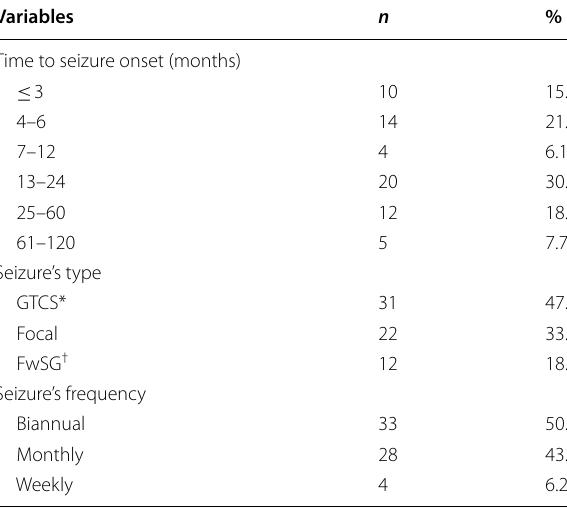
Table 3 Description of seizures in patients